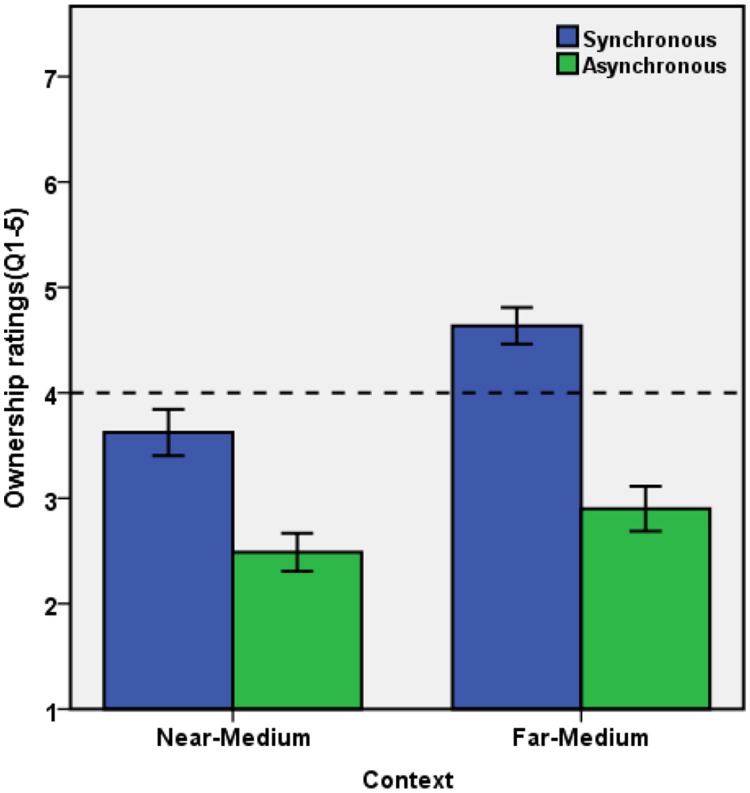
Mean Score of Ownership Questions (Q1–Q5) for test condition. Error bars represent ±1 SE.